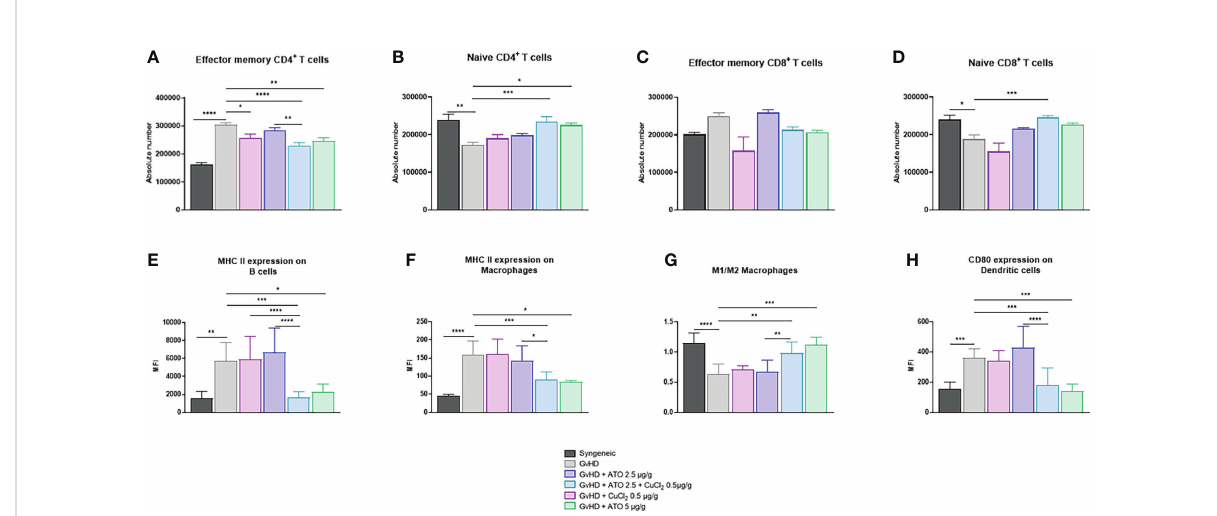
FIGURE 7 Modi fi cation of the adaptive and innate immune system by ATO and CuCl 2. (A – D) Histograms showing the absolute count of spleen effector memory and naive CD4 + and CD8 + T cell populations. (E) Flow cytometry analysis of splenic B cells. (FA – H) Flow cytometry analysis of splenic macrophages and dendritic cells. Splenic T cells were gated on CD3 + - and CD4 + - or CD8 + -positive cells. Splenic B cells were gated on CD3 - B220 + . Macrophages were gated on F4/80 + CD11b + . Dendritic cells were gated on CD11c + CD11b + . The gating strategy has been added as additional data (Supplementary Figure 5). *p <0.05; **p<0.01; ***p<0.001; ****p<0.0001. The results for each group are the mean of the measurements obtained per mouse: syngeneic (n = 7); cGvHD (n = 10); cGvHD-Cu (n = 6); cGvHD-ATO 2.5 µg/g (n = 8); cGvHD- ATO-Cu (n = 11); cGvHD-ATO 5 µg/g (n =